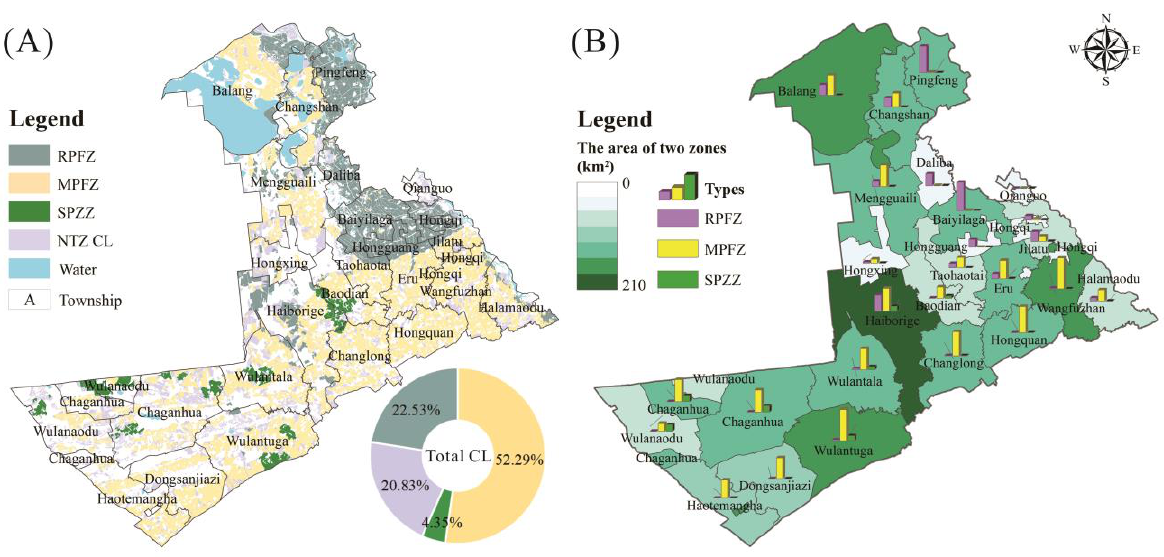
Figure 9. Spatial distribution of the two zones (( A ). Spatial distribution of the two zones; ( B ). Statistics on the amount of CL delineated into two zones).